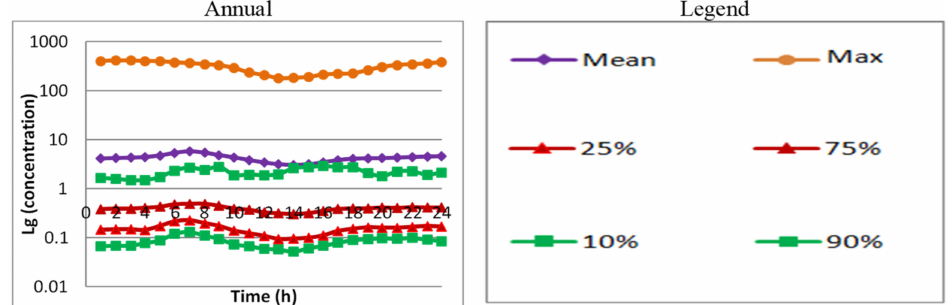
Figure 5. Spatial and diurnal variations of the annual and seasonal ensembles of surface FPRM